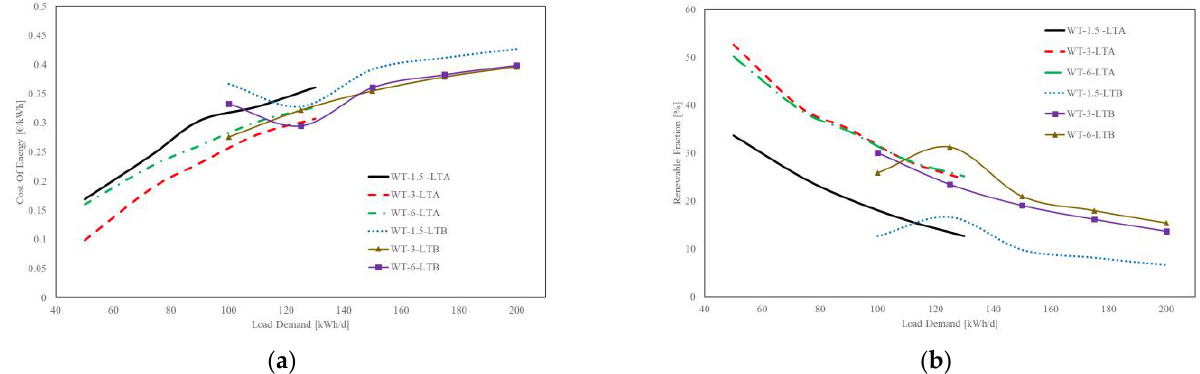
Figure 12. Load demand parametric study for the 2nd examined wind pattern for different wind turbines. ( a ) COE vs. load demand; ( b ) Ren.Fr. vs. load demand.